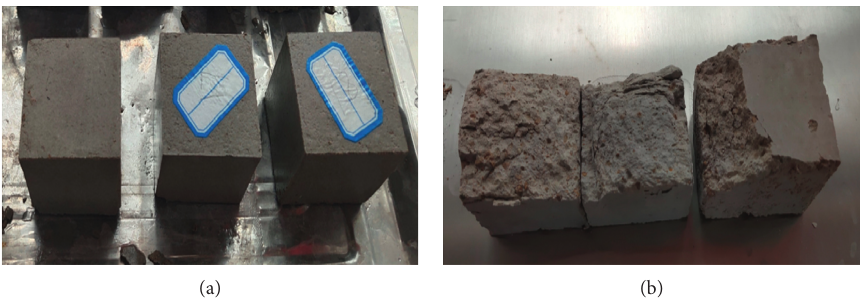
Figure 7: The sample photos before (a) and after (b) freeze-thaw